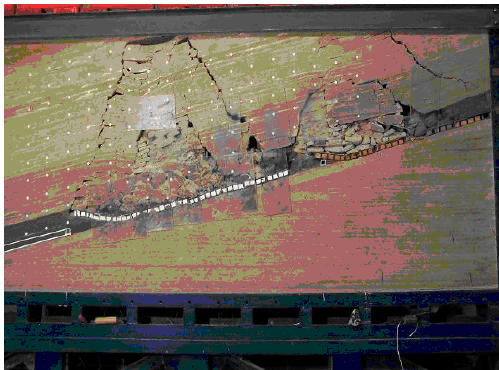
Figure 12. 90 m of the panel is extracted.